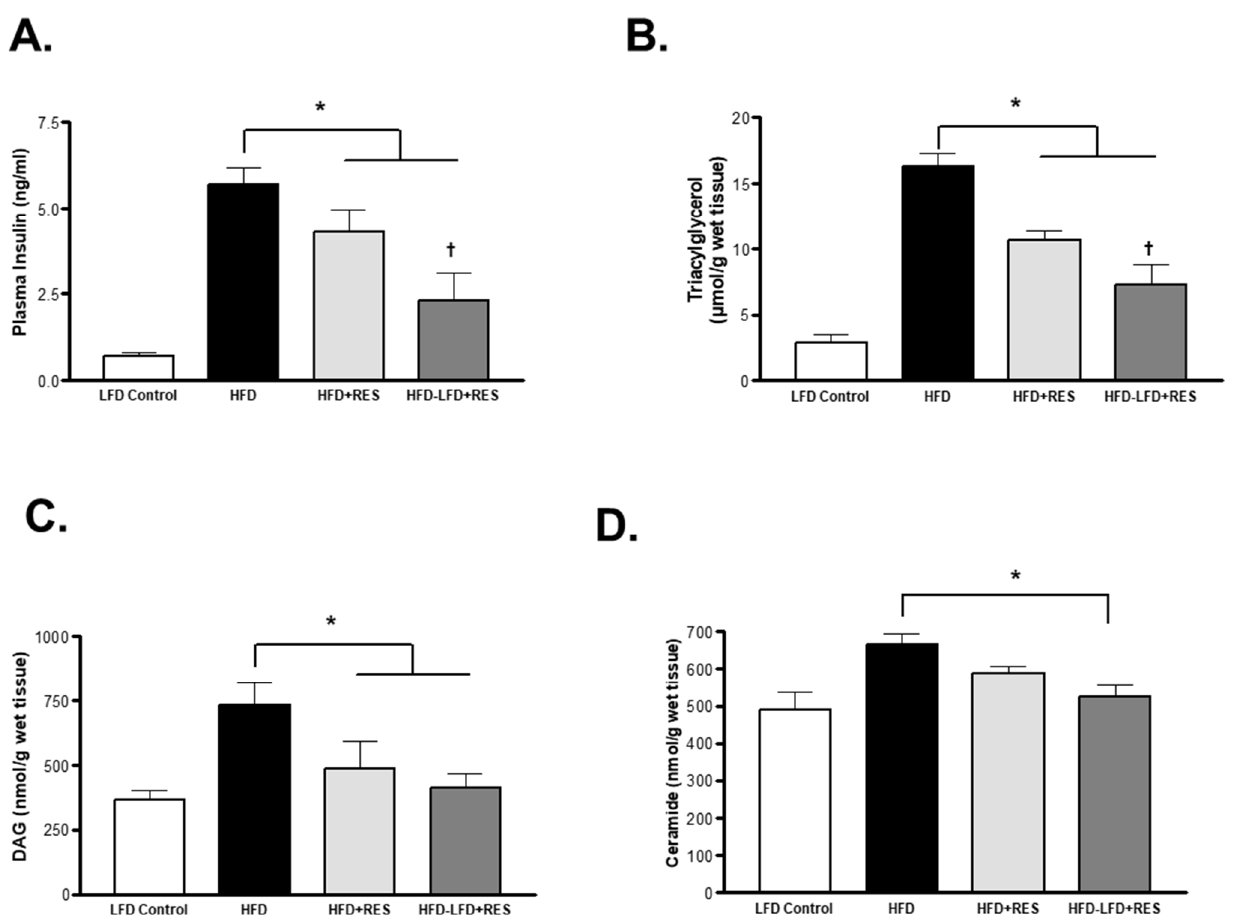
Figure 4. Muscle metabolic profile and plasma insulin levels in HFD treated mice. ( A ): Plasma insulin levels. ( B ): Gastrocnemius triacylglycerol content. ( C ): Diacylglycerol content. ( D ): Ceramide content. * p < 0.05 vs. HFD; † p < 0.05 vs. HFD+RES. Values represents mean ± S.E.M. (n = 6–8).